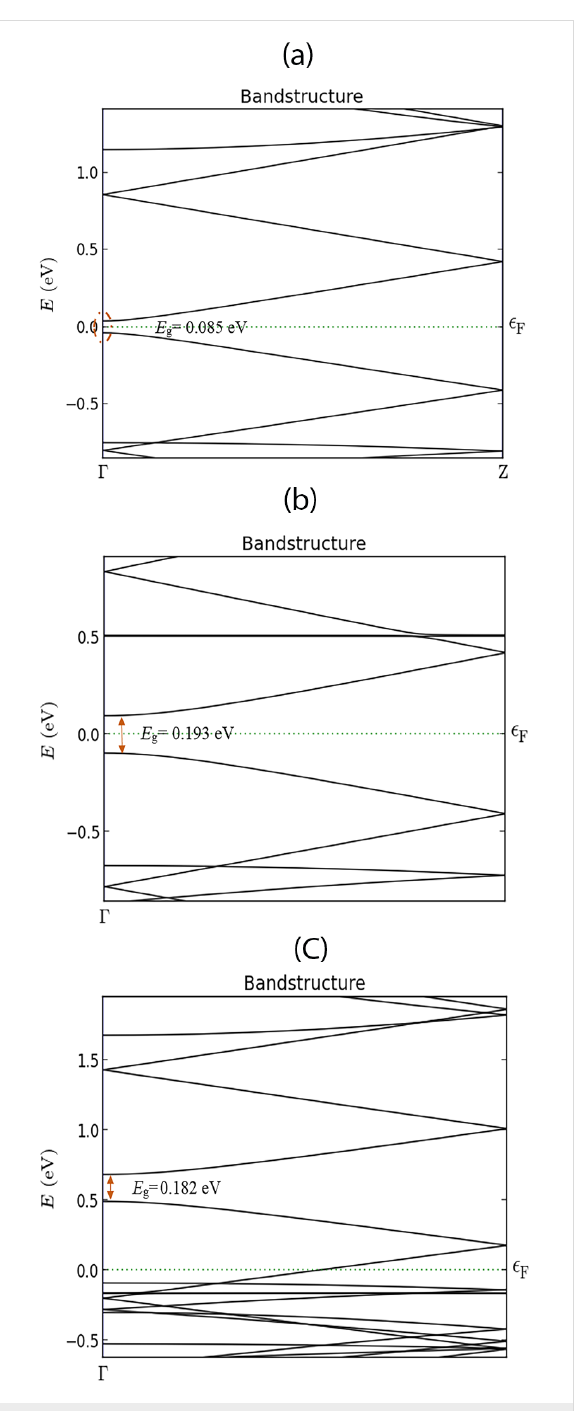
Figure 5: Energy band structure of the 8-AGNR: (a) bare AGNR, (b) after CO adsorption, (c) after NO adsorption.